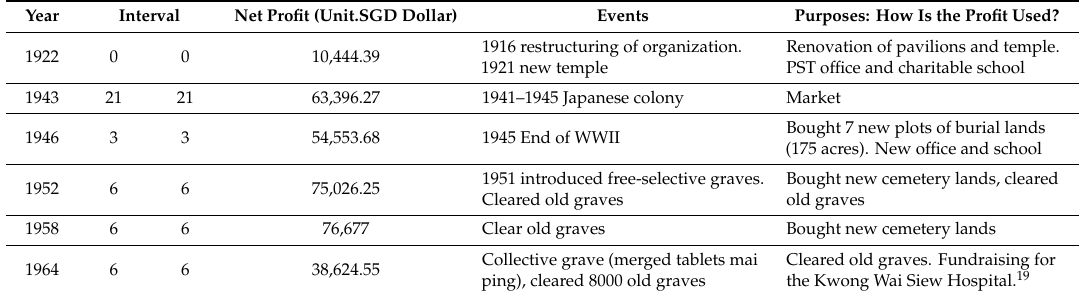
Table 2. Interval, profit and purposes of salvation rituals organized by